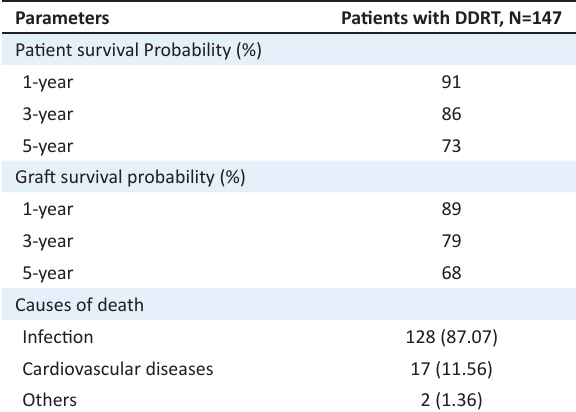
Table 2. Patients’ follow-up data and patient survival and graft survival rate Parameters Patients with DDRT,